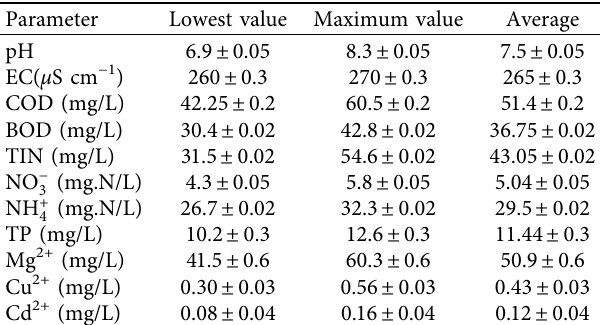
Figure 4: (a) The linear plot of CNC and MA-CNC and (b) the BET plot of CNC and MA-CNC adsorbents. Table 1: Physicochemical properties of the SERWW used in the